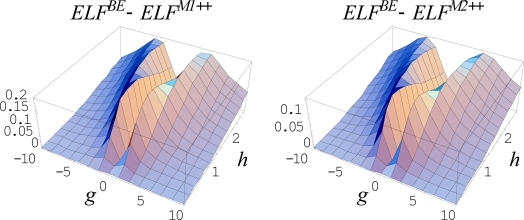
The same kid of representation as in Figure 11, yet here for marking the Markovian (M1++) and (M2++) behaviors of Equations (501) and (502), in left and right, respectively.